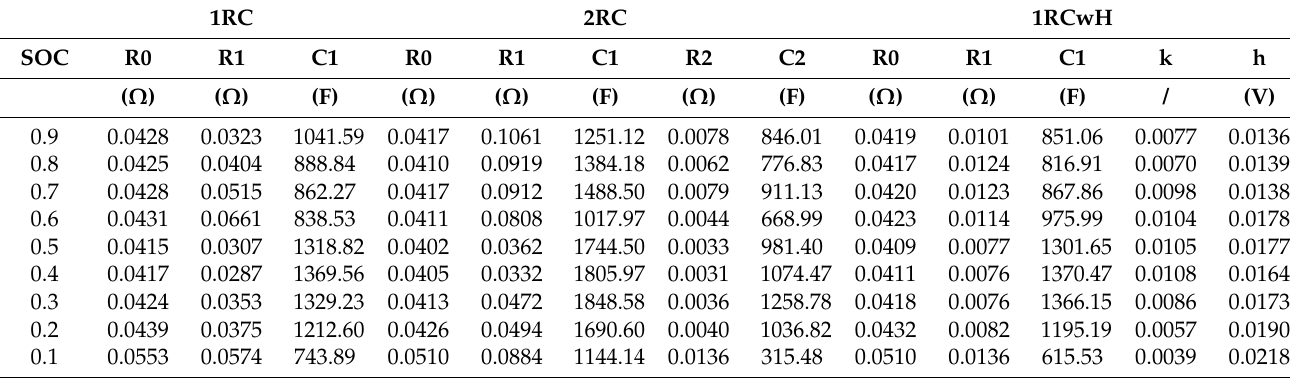
Table 8. Model parameters obtained from HPPC data fitting in MATLAB for the LMO cell.